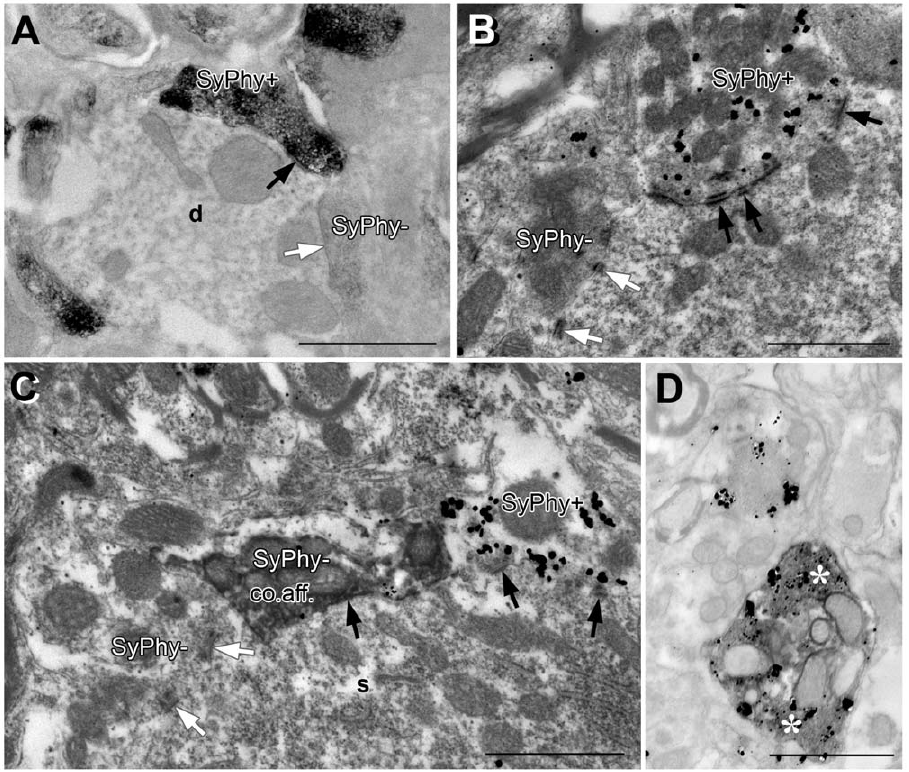
Figure 2. SyPhy immunoreactivity in AVCN detected under the electron microscope. (A) Staining with DAB already indicated that presynaptic profiles were not quantitatively recognized. Black arrows point to SCZs of immunopositive (SyPhy + ) synapses, white arrows point to immunonegative (SyPhy-) synapses, always pointing from the postsynaptic side to an AZ; d = dendritic profile. (B) Immunogold staining (black particles) confirmed finding illustrated in A; same conventions and scale length. (C) Combining SyPhy immunolabeling with anterograde axonal transport of BDA from cochlear to AVCN proved that primary sensory synapses of various size do not dependably contain SyPhy, with nearby presynaptic profiles massively labeled for SyPhy through immunogold staining. Black arrows point to SCZs of a BDA-positive (co.aff.) or a SyPhy- positive synapses, white arrows point to an SCZ of a synapse negative for both BDA and SyPhy; s = neuronal soma. (D) Immunogold (SyPhy, black particles) and DAB (ChAT, white asterisks) double staining, indicating absence of interference between both procedures. Scale bar =1 m m for (A) – (D).